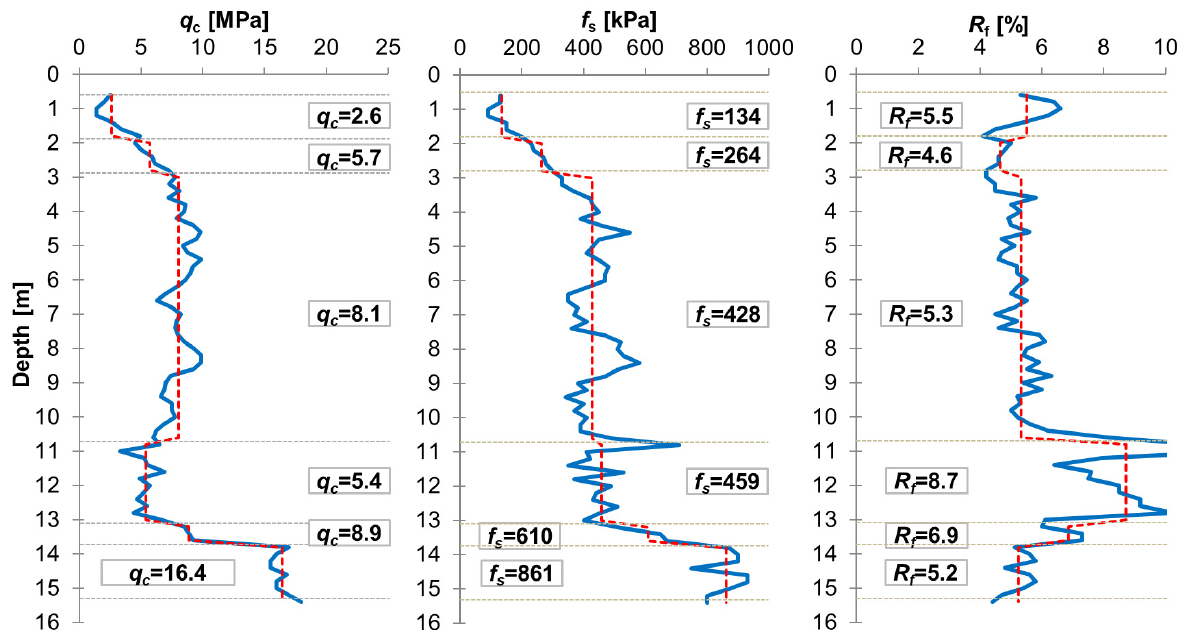
Figure 5. CPT-1 parameters.